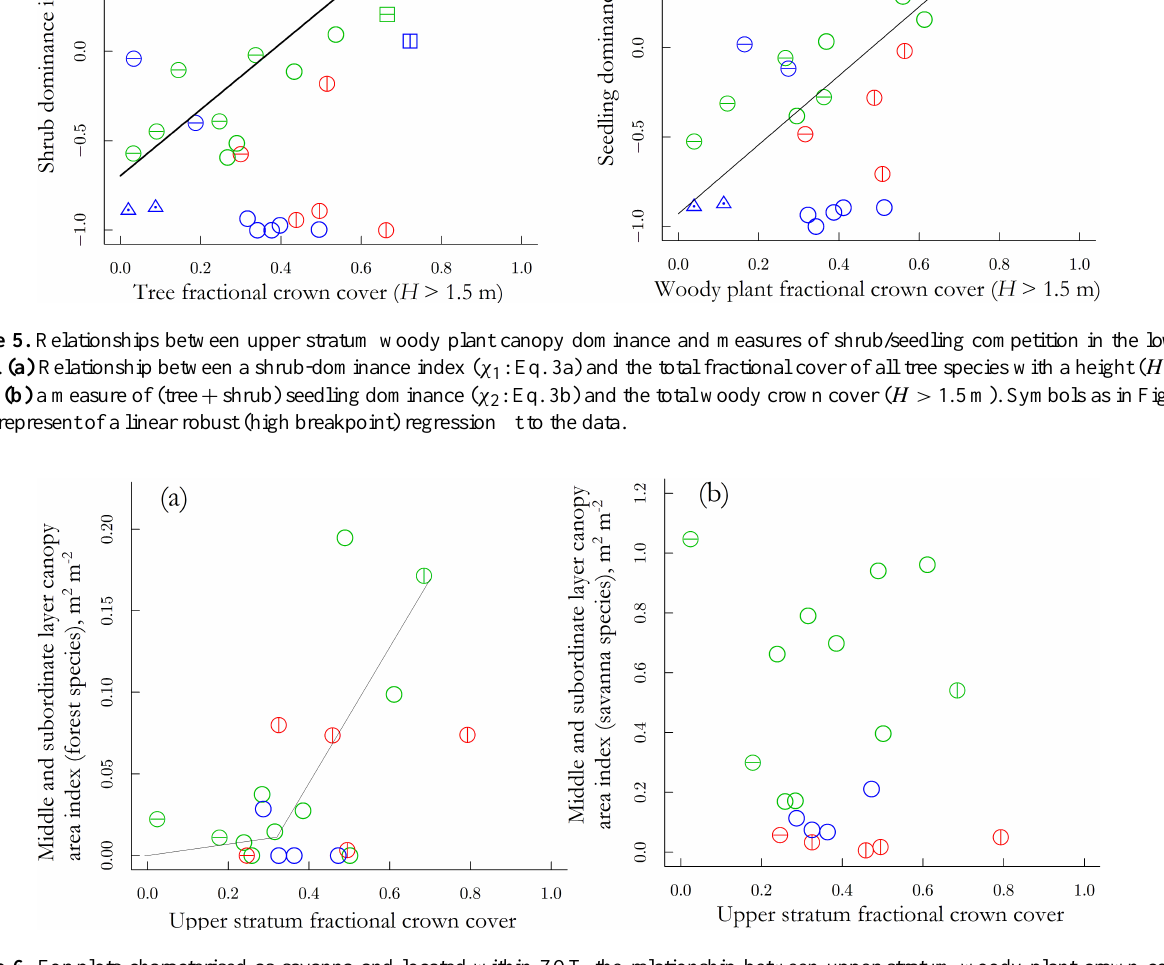
Figure 6. For plots characterised as savanna and located within ZOT, the relationship between upper stratum woody plant crown cover and (a) [middle + subordinate] forest-species canopy area index and (b) savanna species [middle + subordinate] layer canopy area index. Symbols as in Fig. 1. Note the different scales for the y